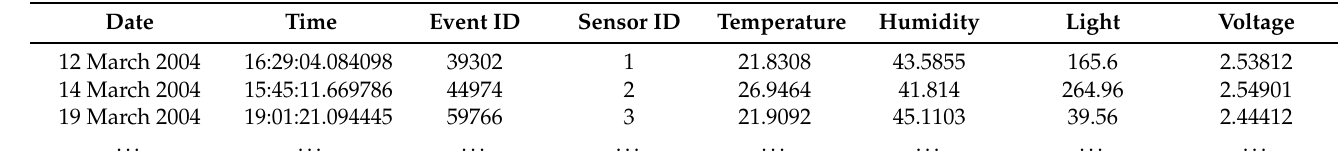
Table 4. Samples of the Intel Berkeley dataset.